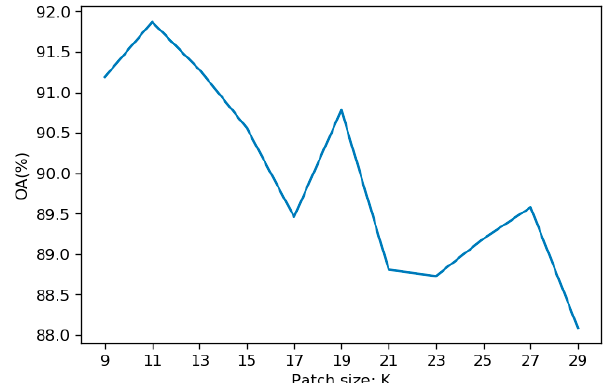
Figure 5. Patch size k vs. overall accuracy.